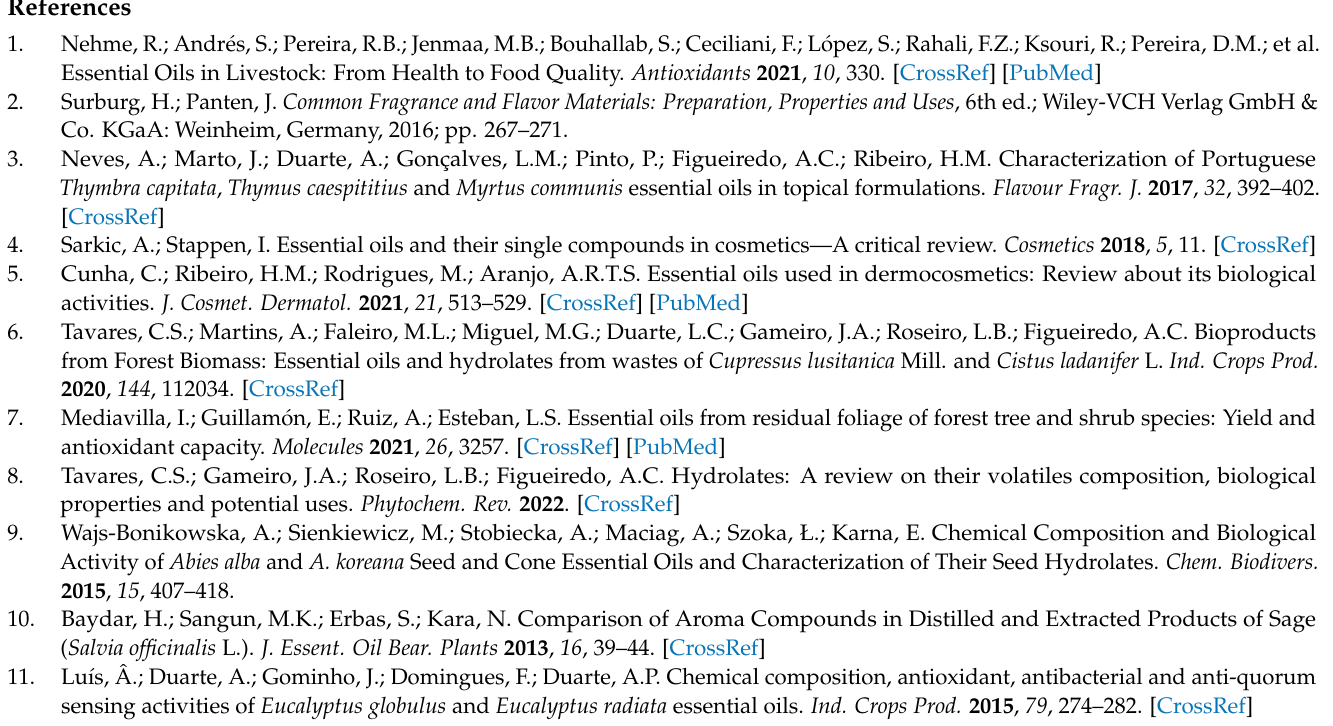
Table S5. Percentage composition of Eucalyptus globulus hydrolates volatiles. For samples codes vide Table 10 in Materials and Methods section. Table S6. Percentage composition of Pinus pinaster hydrolates volatiles. For samples codes vide Table 10 in Materials and Methods section. Table S7. Percentage composition of Cryptomeria japonica hydrolates volatiles. For samples codes vide Table 10 in Materials and Methods section. Sensory Questionnaire (English